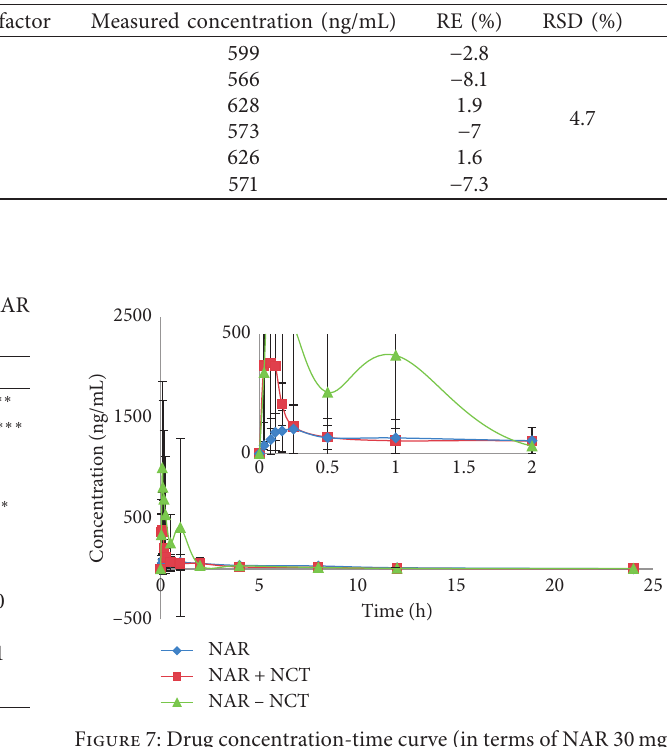
Table 3: Dilution reliability of NAR plasma samples ( n � 6).